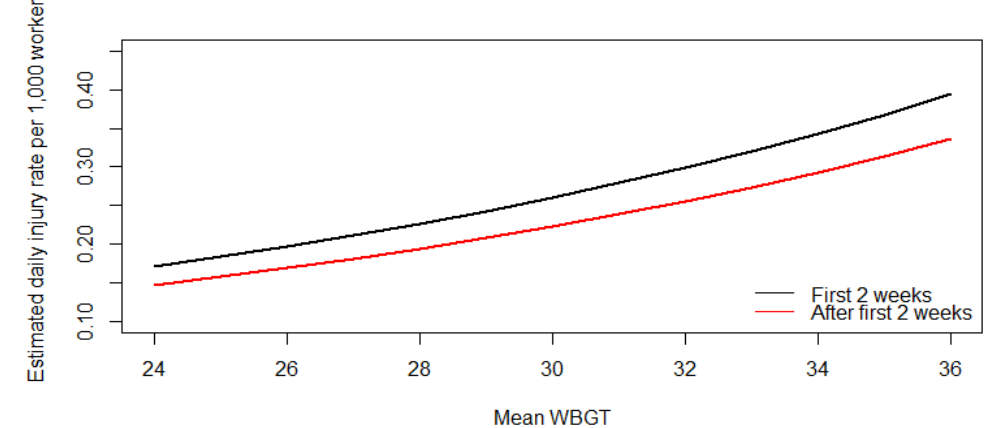
Figure 3. Estimated daily total recorded occupational injury rate per 1000 sugarcane harvesters with daily WBGT mean temperatures for the 2014–2015 harvest with the assumption of an average of 6 tons of sugarcane harvested per day.